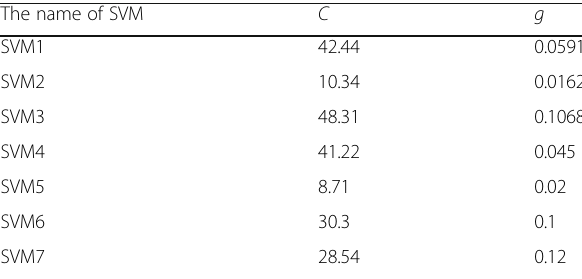
Table 13 Parameter values of each SVM after genetic algorithm optimization The name of SVM